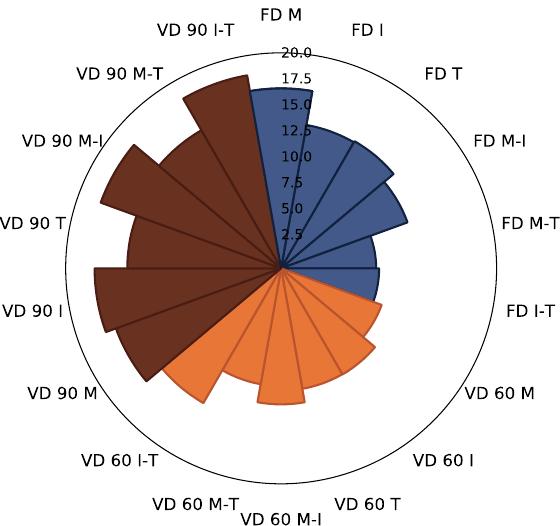
Figure 5. The radar plot of HMF in chokeberry pomace extract powders gained with the addition of maltodextrin (M), inulin (I), trehalose (T), maltodextrin—inulin (M-I), maltodextrin—trehalose (M-T) and inulin—trehalose (I-T) by freeze drying (FD) and vacuum drying at 60 (VD 60) and 90 °C (VD 90) ( n = 2) (μg/100 g db).